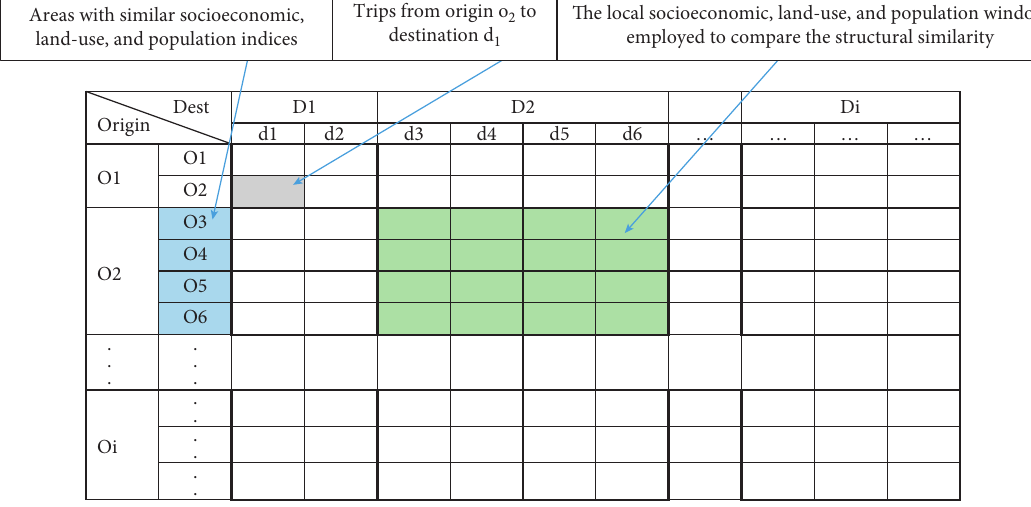
Figure 4: Application of the suggested method on a presumed matrix.